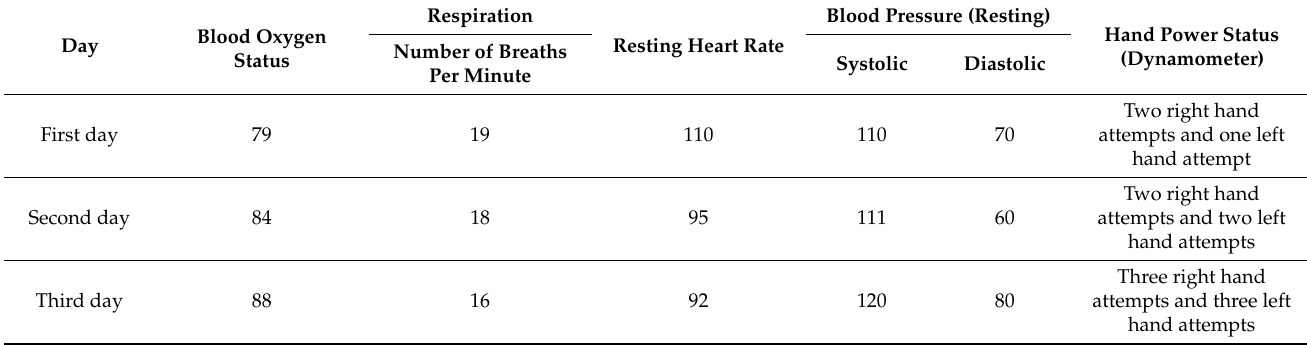
Table 1. Results for the factors involved in COVID-19 after the training